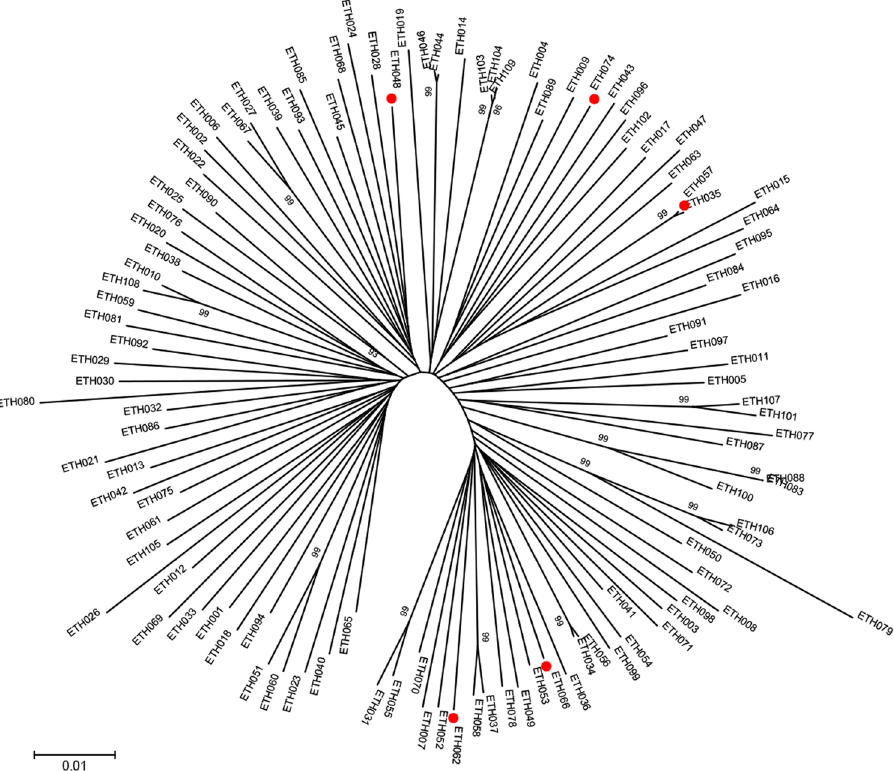
Figure 2. Maximum likelihood phylogenetic analysis of the 109 sequences generated by next generation sequencing. Sequences with INSTI mutations are highlighted in red for comparison with other